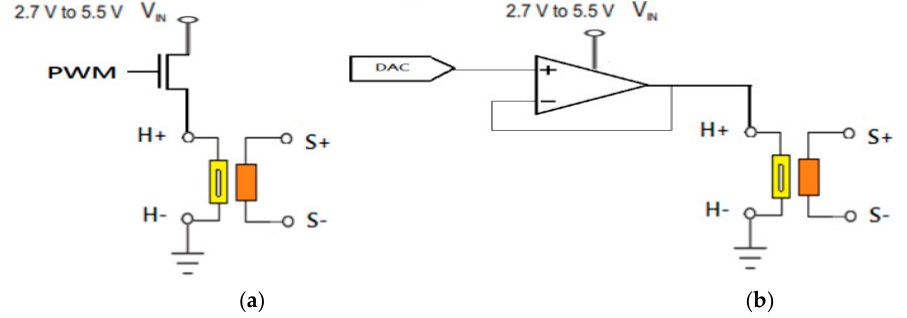
Figure 8. Traditional driver circuit for a gas-sensor microheater: ( a ) PWM driver, ( b ) linear driver (buffer circuit).